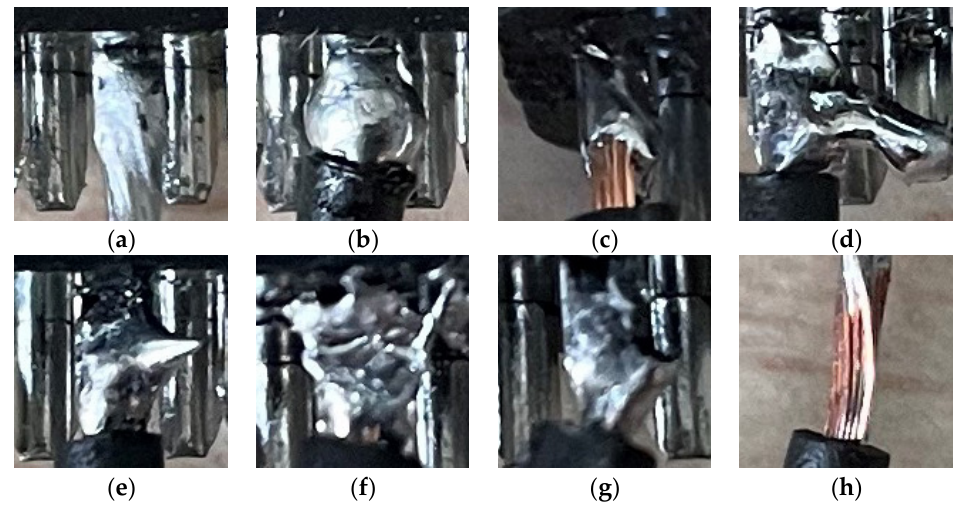
Figure 4. Type of the solder joint to be detected: ( a ) qualified solder, ( b ) multi-solder, ( c ) less-solder, ( d ) connected-solder, ( e ) tin-solder, ( f ) rough-solder, ( g ) skewed wire, and ( h ) bare wire.